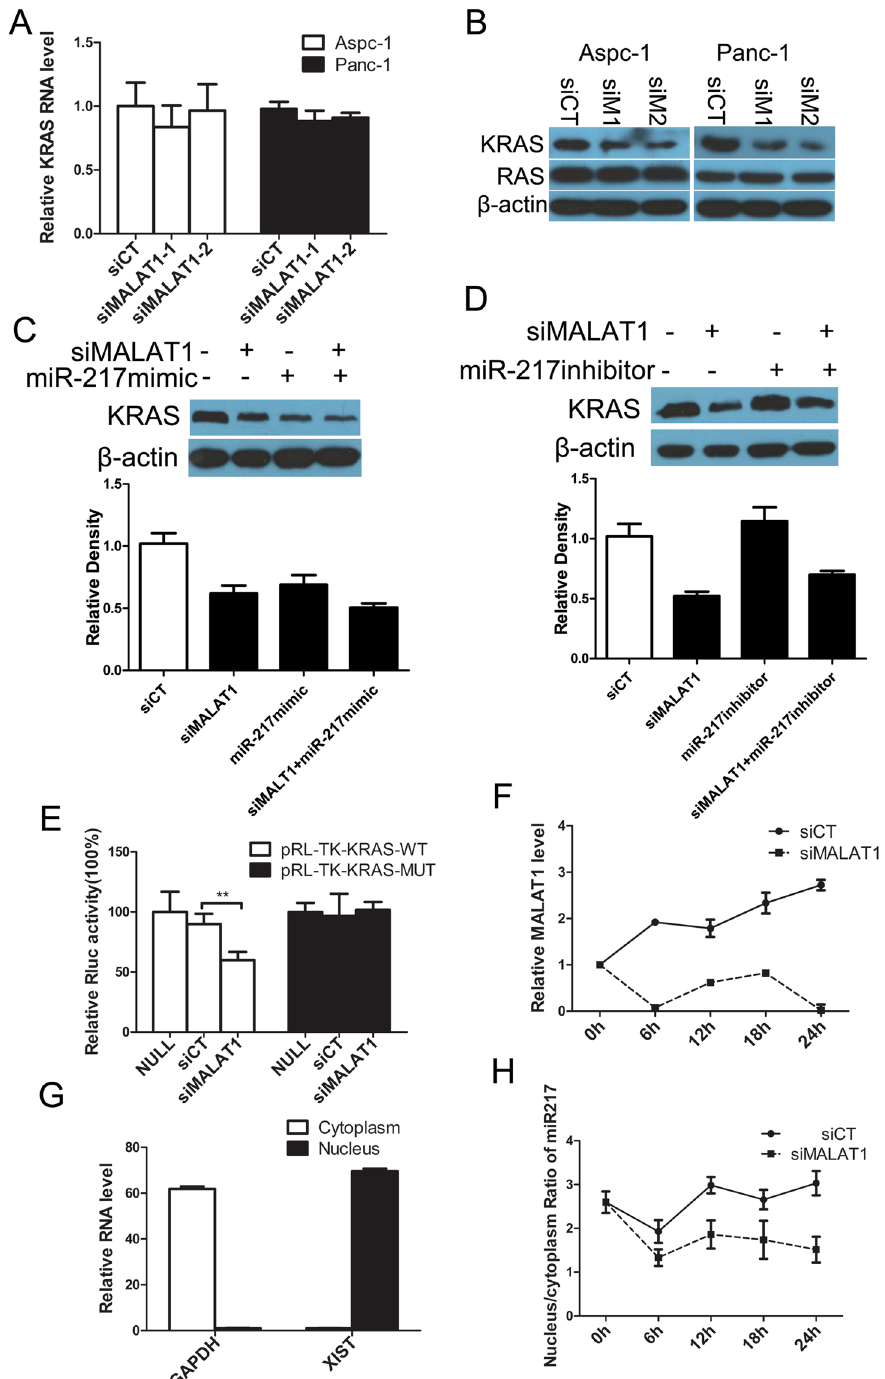
Figure 6. MALAT1 regulates KRAS expression in pancreatic cancer cells by interacting with miR-217. ( A ) KRAS mRNA expression after MALAT1 knockdown in pancreatic cancer cells. ( B ) KRAS and RAS protein expression after MALAT1 knockdown in pancreatic cancer cells. β -actin was used as a loading control. siCT: negative control siRNA, siM1: siMALAT1-1, siM2: siMALAT1-2. ( C ) KRAS protein expression in pancreatic cancer cells after the cells were transfected with negative-control siRNA (siCT) or siMALAT1 with or without an miR-217 mimic or miR-217 inhibitor ( D ). The full-length gels and blots for KRAS protein are included in Fig. S5. ( E) Luciferase reporter gene expression after pRL-TK-KRAS-WT vectors or pRL-TK-KRAS-MUT vectors were transfected into pancreatic cancer cells along with either siMALAT1 or negative-control siRNA (siCT). ( F ) MALAT1 downregulation after pancreatic cancer cells were transfected with siRNAs. ( G ) XIST and GAPDH RNA levels in the nuclear and cytoplasmic fractions, as determined by qPCR. ( H ) miR-217 nucleus/ cytoplasm ratios in pancreatic cancer cells after the cells were transfected with siCT or